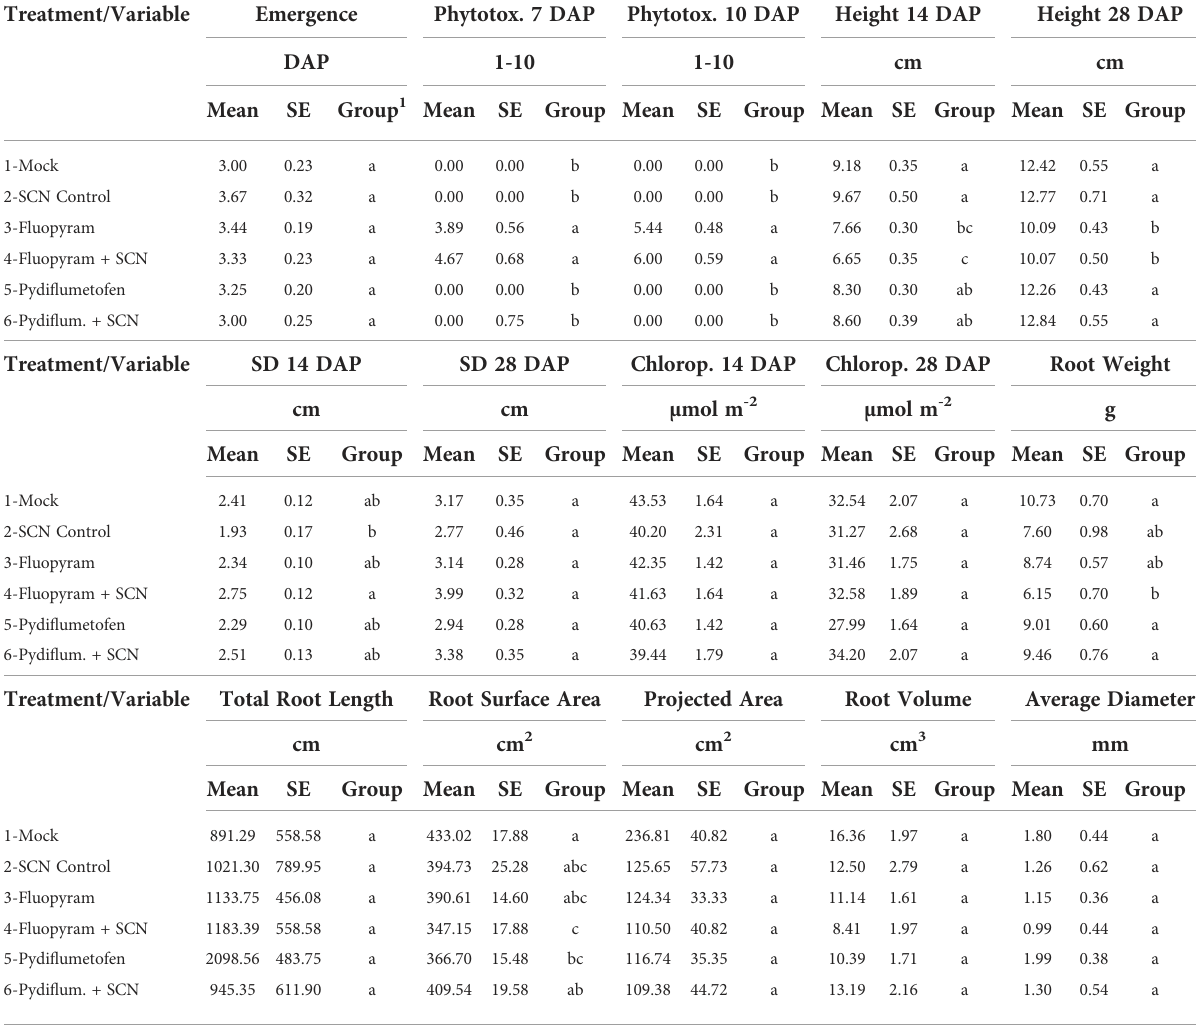
TABLE 3 Effect of seed treatments on plant emergence, phytotoxicity, growth parameters, and root measurements. Treatment/Variable Emergence